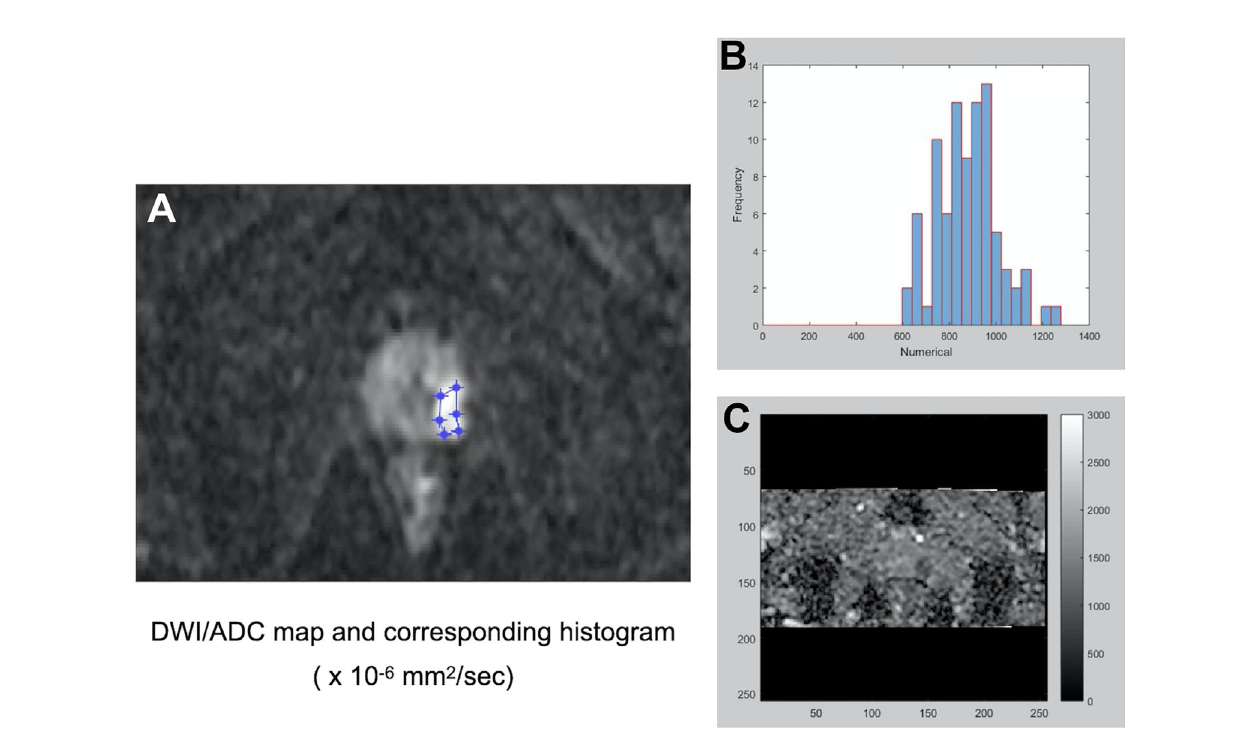
FIGURE 2 | A representative PCa with a preoperative Gleason score of 3 + 3 for the histogram analysis of DW imaging measures. After identifying the dominant tumor nodule in the prostate gland, a region of interest (ROI) was delineated manually on a conventional DWI image (b = 1500 s/mm 2 ) (A) to obtain an ADC map and the corresponding histogram (B) of the ADC map (C) .